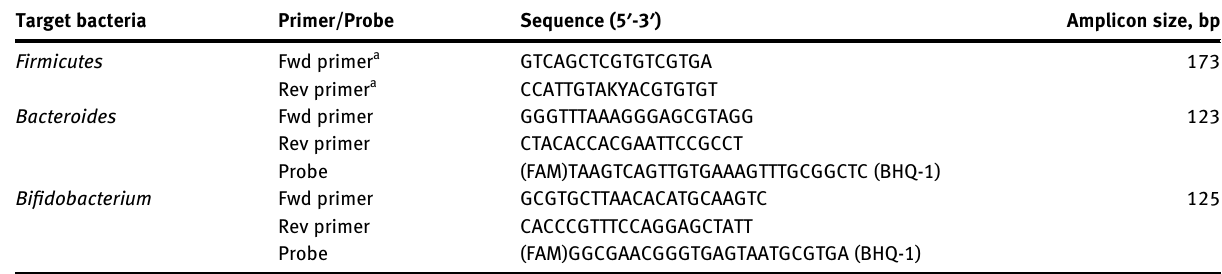
Table  : Primers and probes used in the study for real-time qPCR. Target